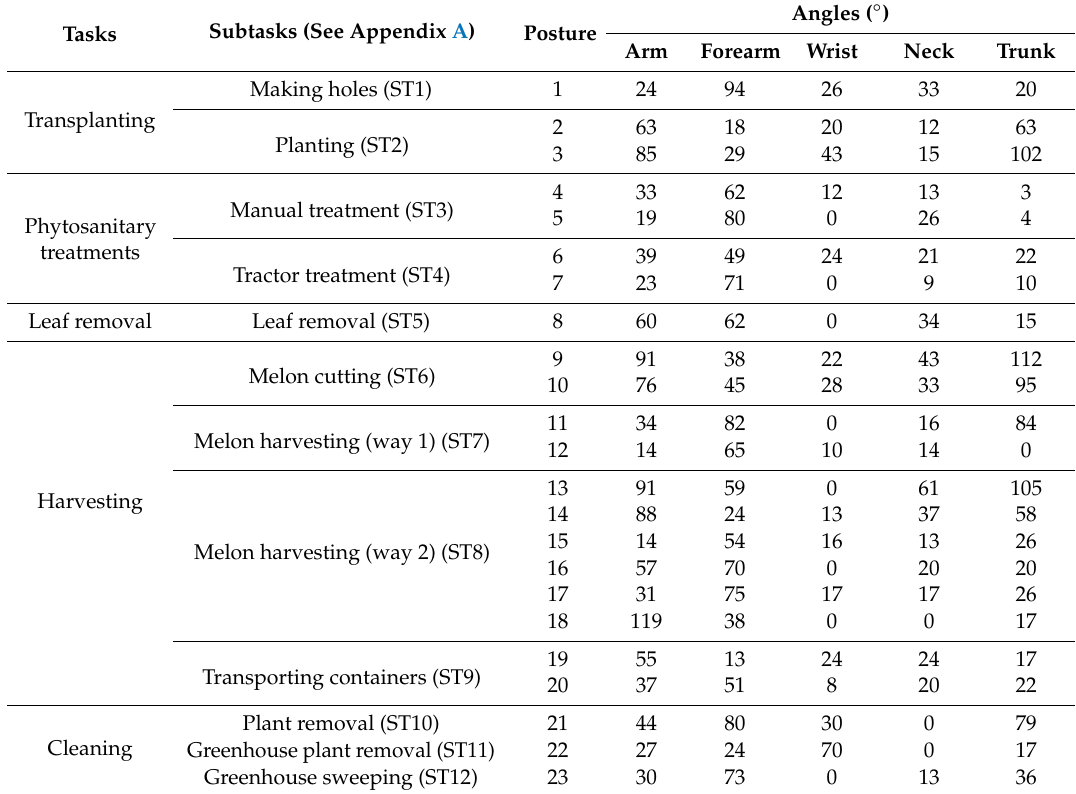
Table 3. Angles about the postures of each